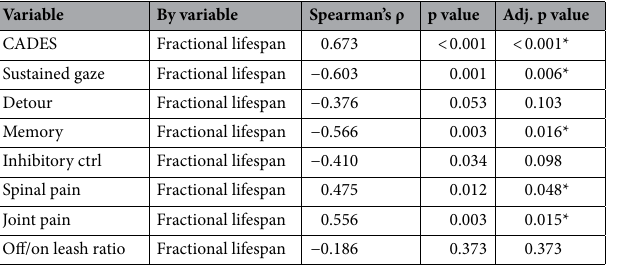
Table 1. Multivariable non-parametric analysis showing the correlation between the variables analyzed in this study. Significant differences (p < 0.05) are indicated by an asterisk.